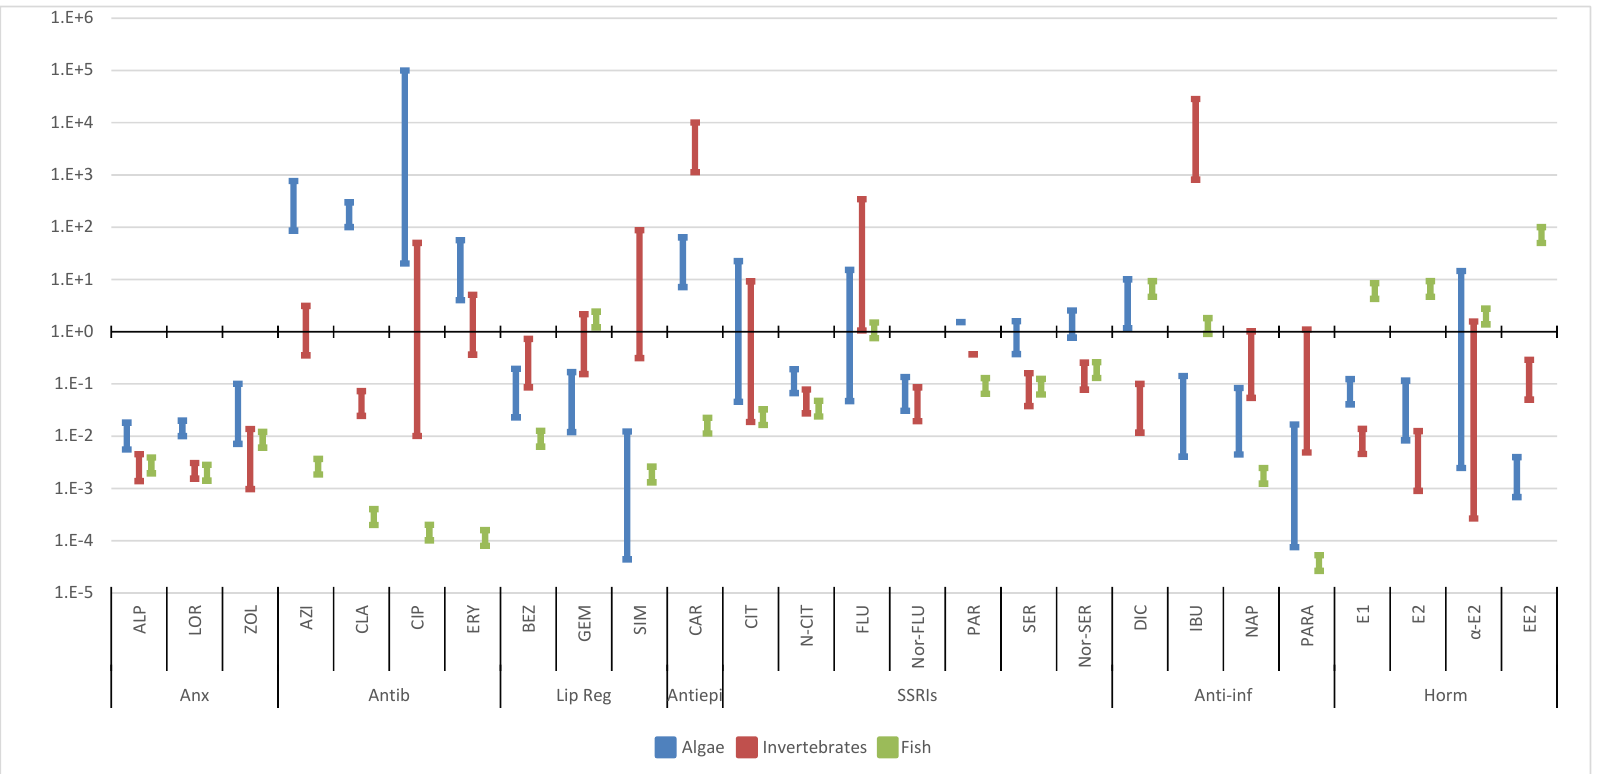
Figure 5. Median and maximum risk quotients of pharmaceuticals in WWEs for the three trophic levels. (Anx—anxiolytics; Antib—antibiotics; Lip reg—lipid regulators; Antiepi—antiepileptics; SSRIs—Selective serotonin reuptake inhibitors; Anti-inf—anti-inflammatories;